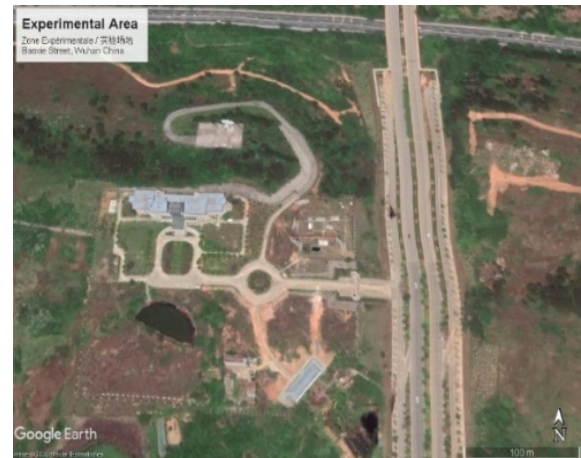
Figure 5. Experimental Area of Baoxie, Wuhan